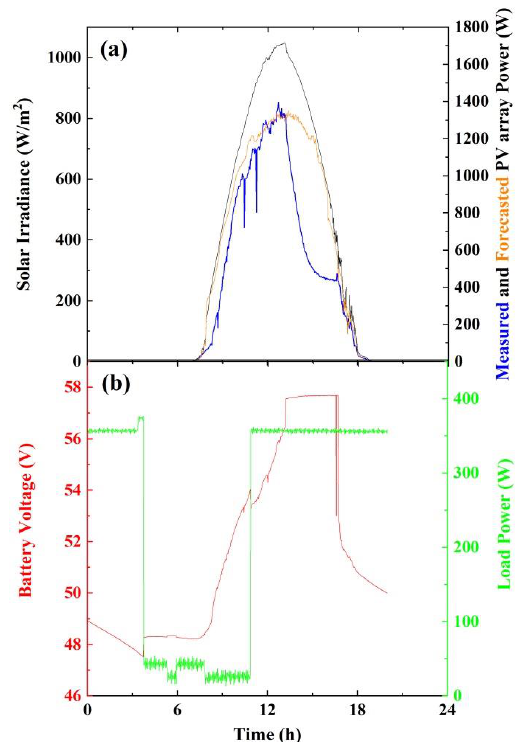
Figure 6. ( a ) Variations of solar irradiance (yellow curve), measured PV output (blue curve), and calculated PV output (orange curve) as a function of time; ( b ) variation of battery voltage (red curve) and applied load (green curve) as a function of time.